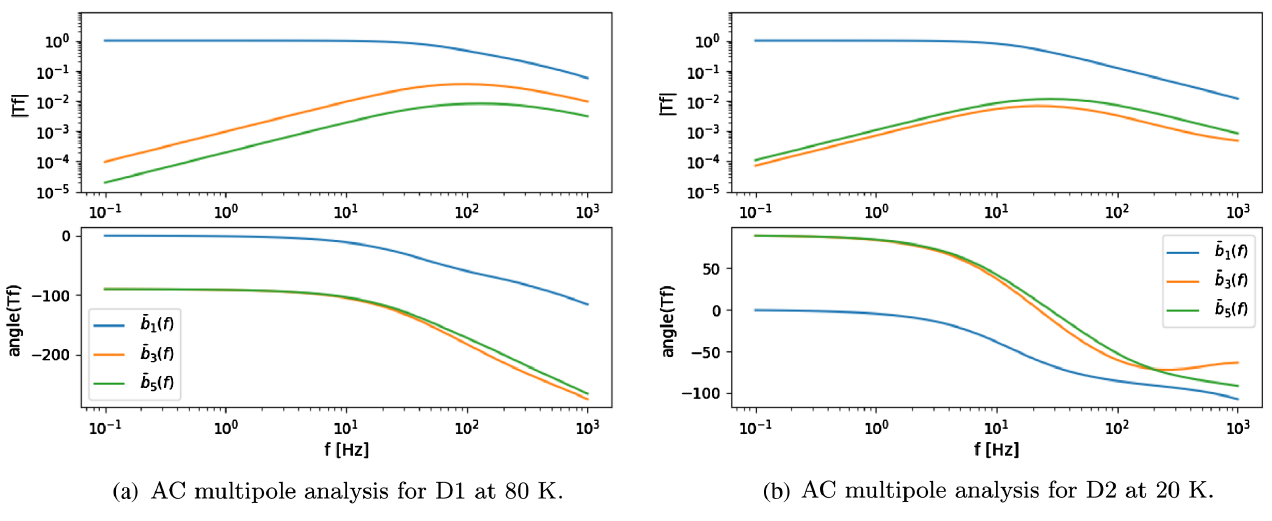
FIG. 11. AC multipole analysis for the beam screens of the HL-LHC separation-recombination